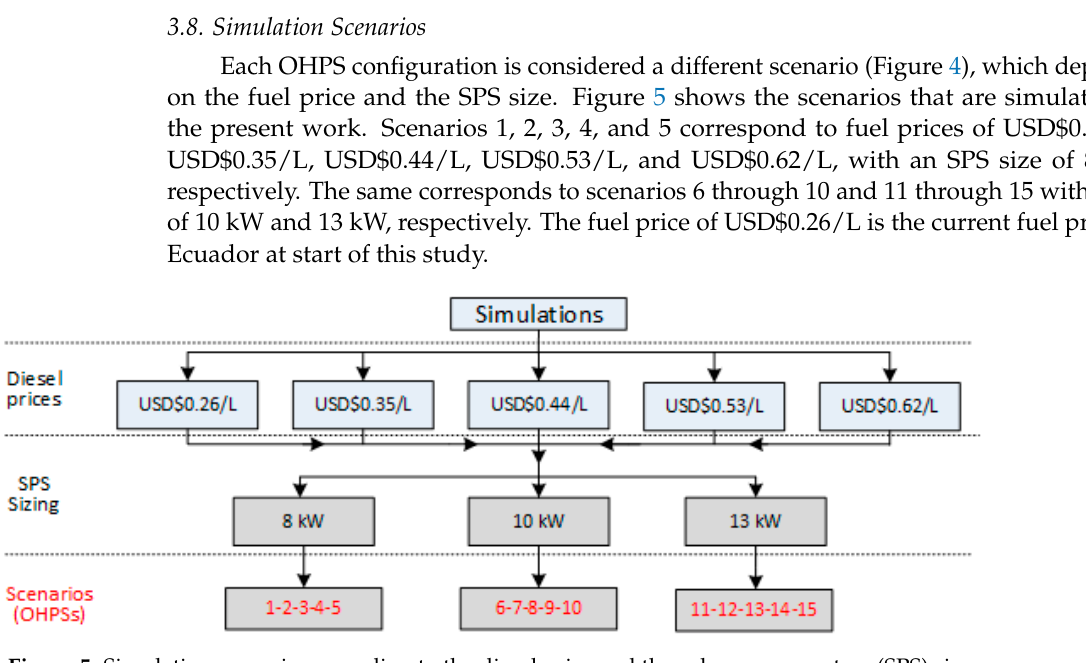
Figure 5. Simulation scenarios according to the diesel price and the solar power system (SPS) size.